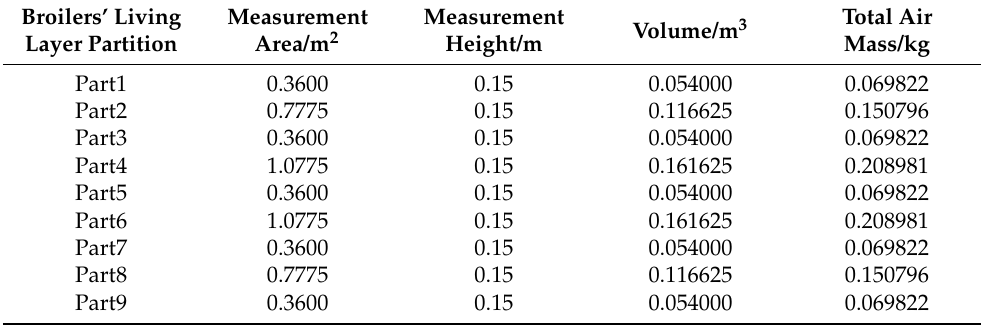
Table 2. Measured values of air mass in the block areas of the broiler